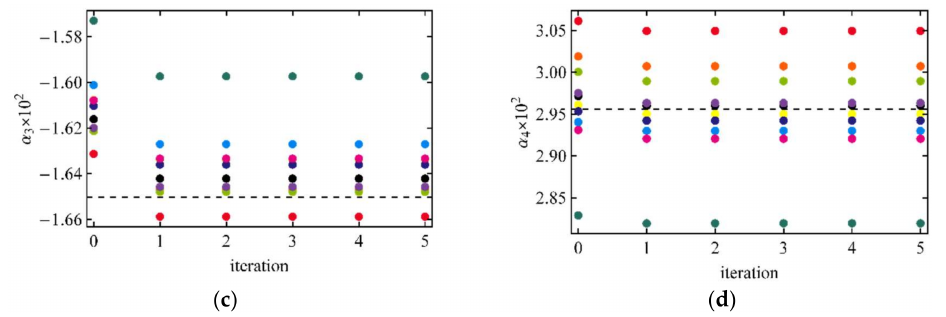
Figure 2. The same as Figure 1 but with τ A = 1.0 and for 10 random realizations of 60 observations.